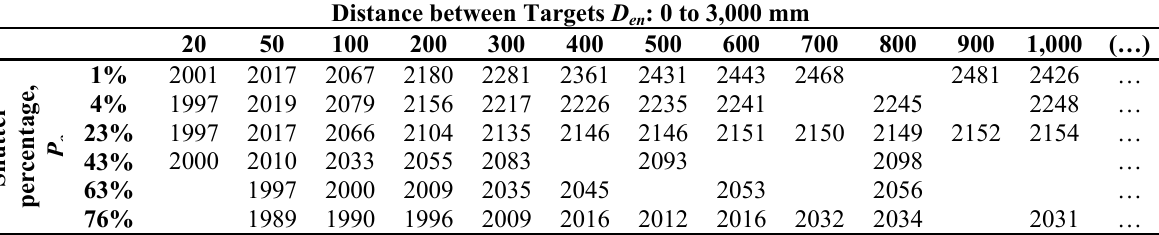
Table 3. Distances in mm given by the LMS200 sensor when the beam at 90° was progressively blocked with the shutter template at a distance (D ) of 2,000 mm from the 1 sensor, with different values of D ranging between 0 and 3,000 mm. Only part of the en results obtained are shown here.